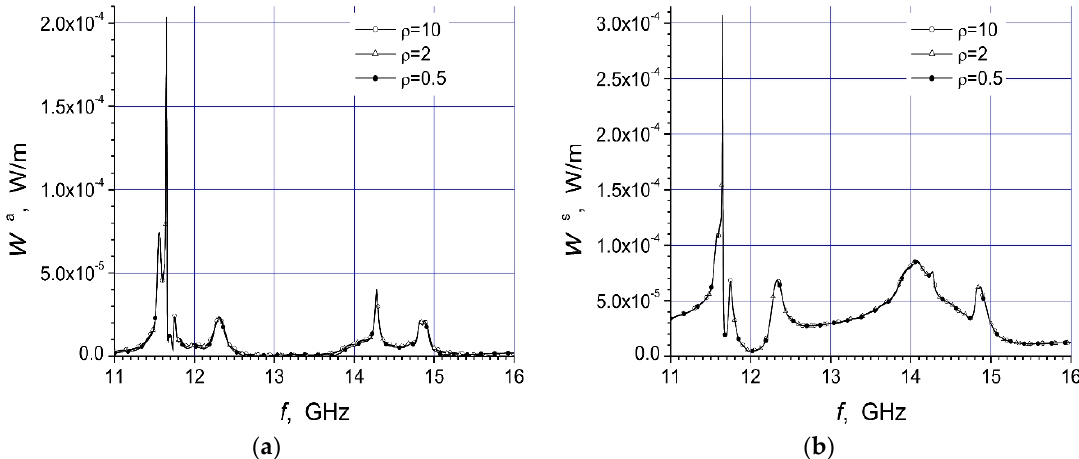
Figure 6. Dependencies of absorbed power ( a ) and scattered power ( b ), of the array Figure 1a, on the frequency of the perpendicular polarized incident wave at R = 12 mm.